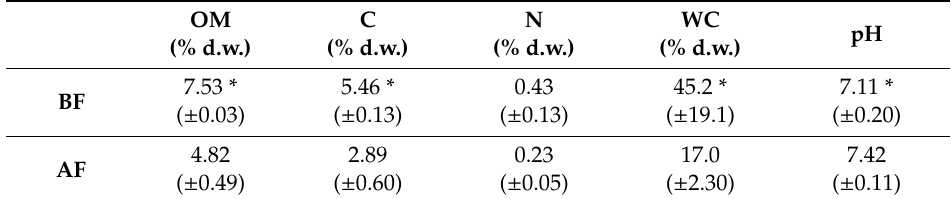
Table 1. Mean values ( ± s.e.) of organic matter content (OM), total contents of carbon (C), nitrogen (N), and water (WC), and pH in soils collected inside the Vesuvius National Park before (BF) and after (AF) fire occurrence. The asterisks indicate significant di ff erences ( t -test, at least p < 0.05) of each investigated soil property between BF and AF. OM C N WC pH (% d.w.) (% d.w.) (% d.w.) (% d.w.) 7.53 * 5.46 * 0.43 BF ( ± 0.13) ( ± 0.20) AF ( ±